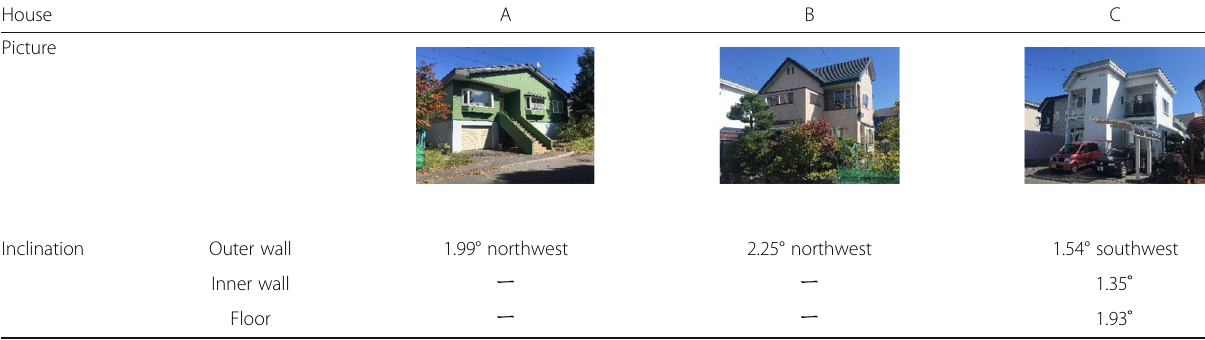
Table 2 Inclination of houses (Utsukushigaoka 1jo, A to C) House A